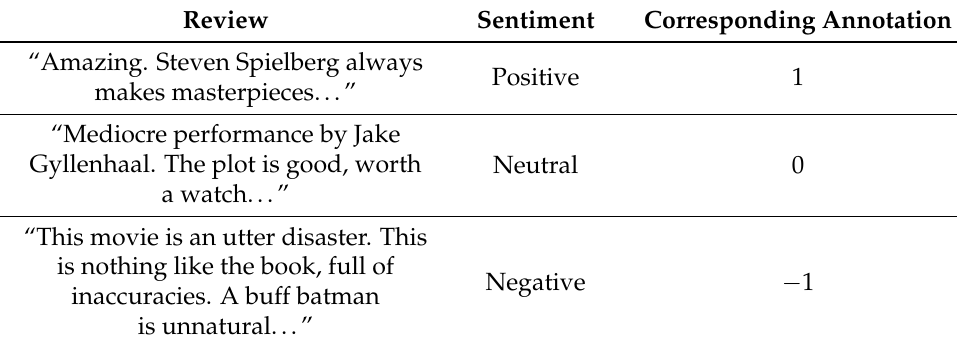
Table 1. Examples of movie reviews for each